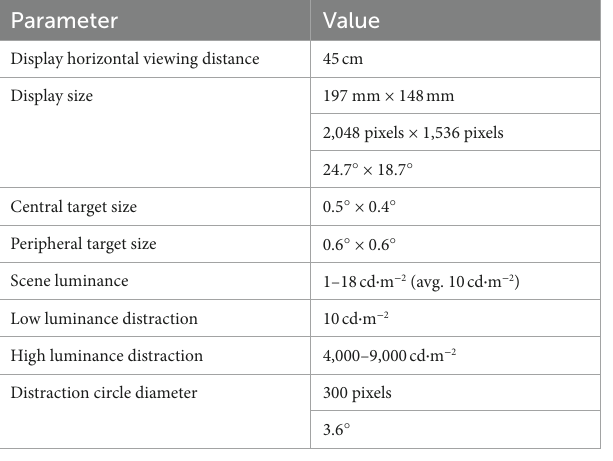
TABLE 1 Parameters for the display system, and the scene and distraction configuration.